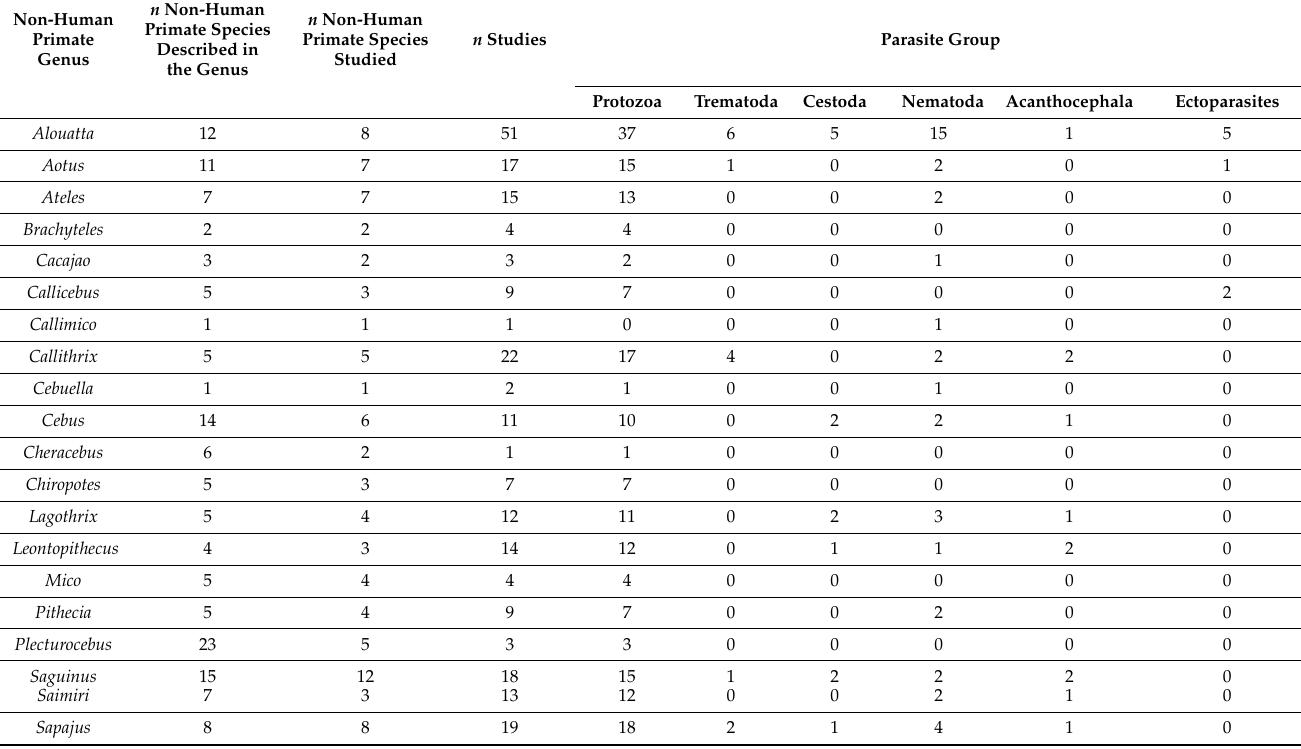
Table 1. Number of articles per parasite group and non-human primate genus.